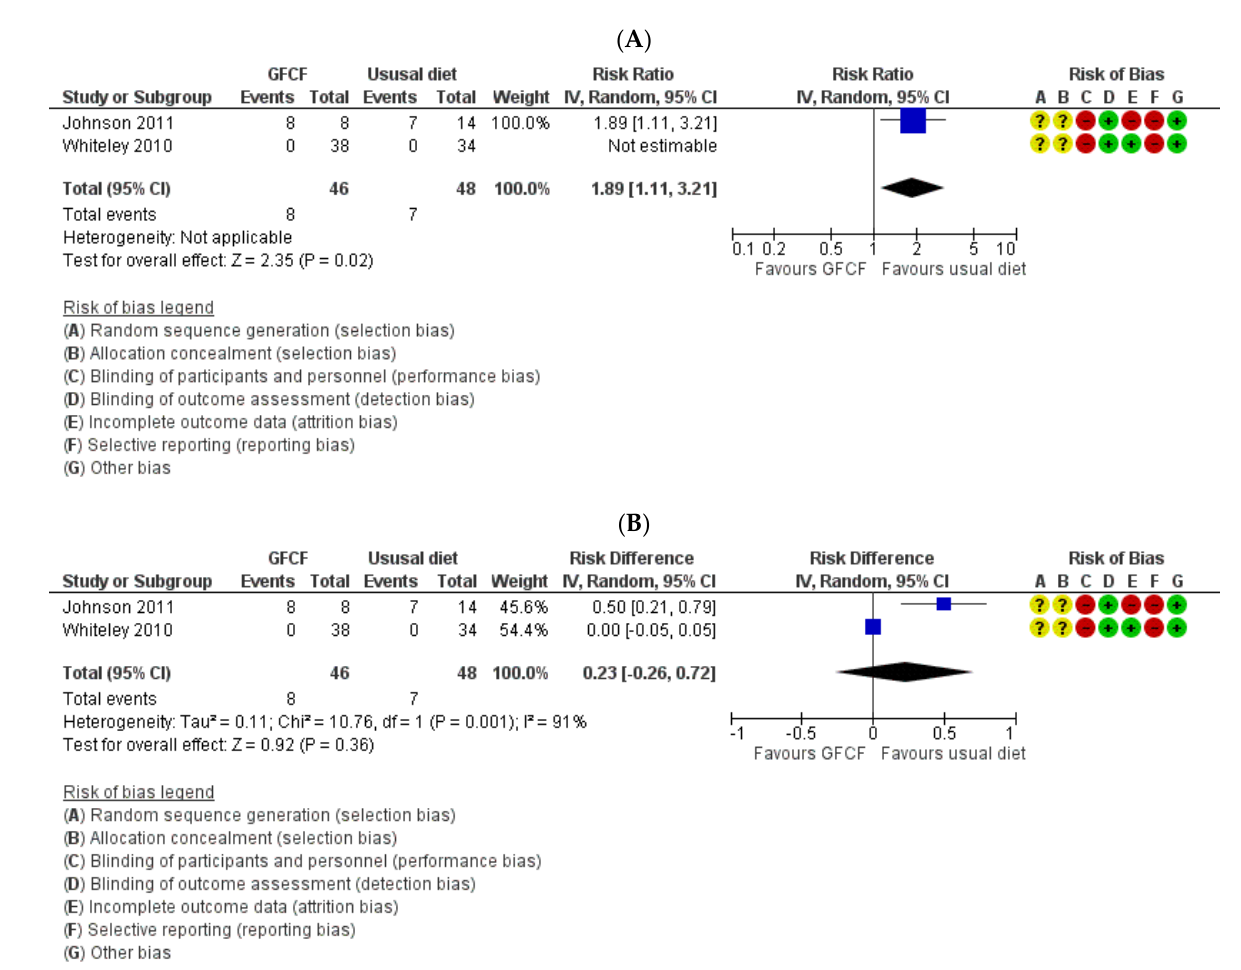
Figure 5. Forest plot of comparison: GFCF vs. usual diet, outcome: number of children with adverse events/side effects. ( A ) Risk ratio; ( B ) Risk difference.